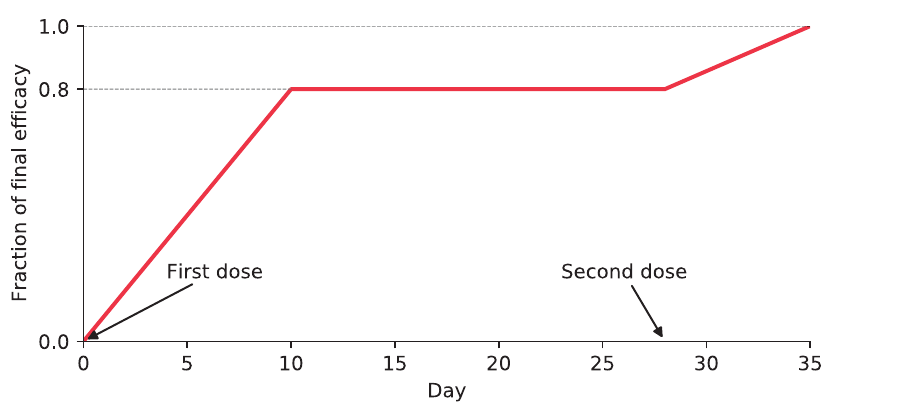
Fig 4. Vaccine allocation scenarios by spatial prioritization, age group, and